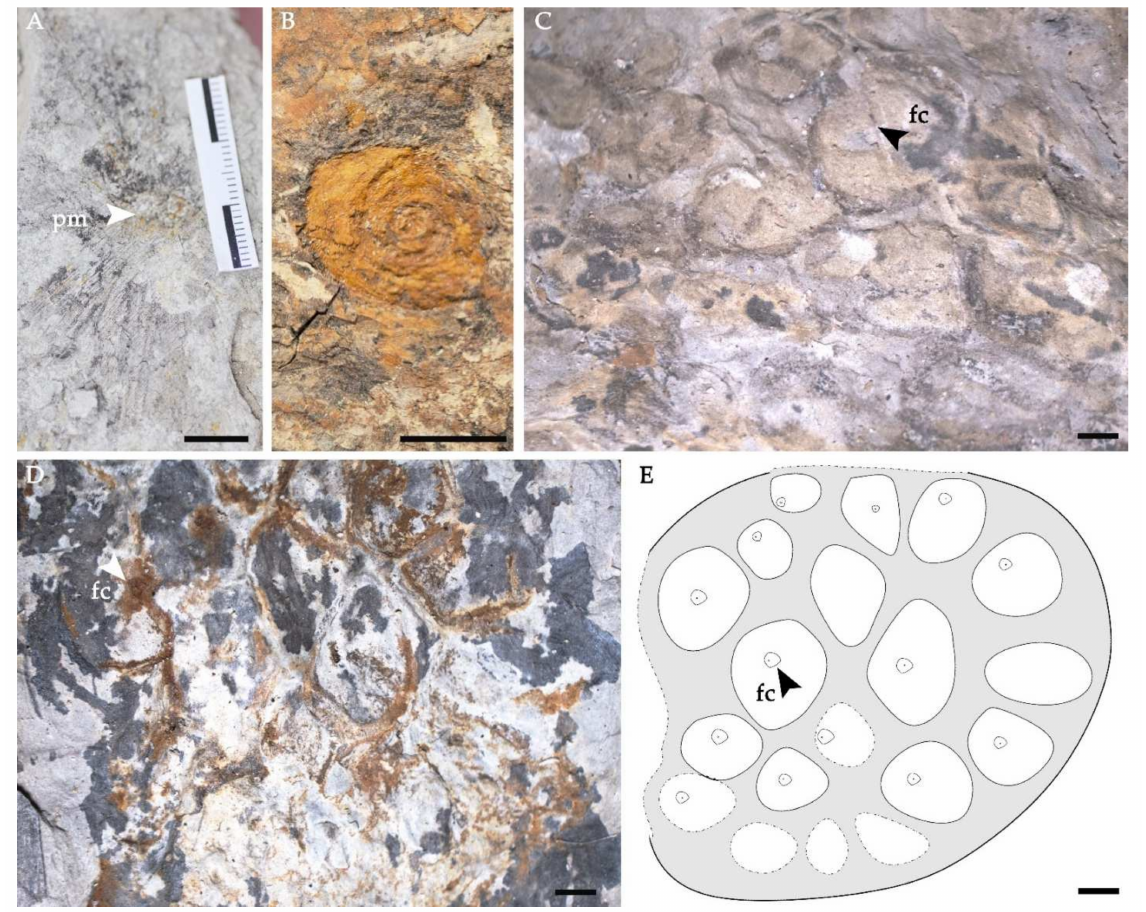
Figure 4. Receptacles, fruits and petiole of Nelumbo delinghaensis sp. nov. ( A ) Receptacle and the point of insertion of the stalk. DLH551, scale bar = 10 mm. ( B ) An individual fruit. DLH560. ( C , D ) Top view of receptacles with fruits. DLH156A, scale bar = 2 mm. ( E ) Interpretative outline drawing of receptacle and fruits, scale bar = 2 mm. (pm: peduncle mould; fc: fruit